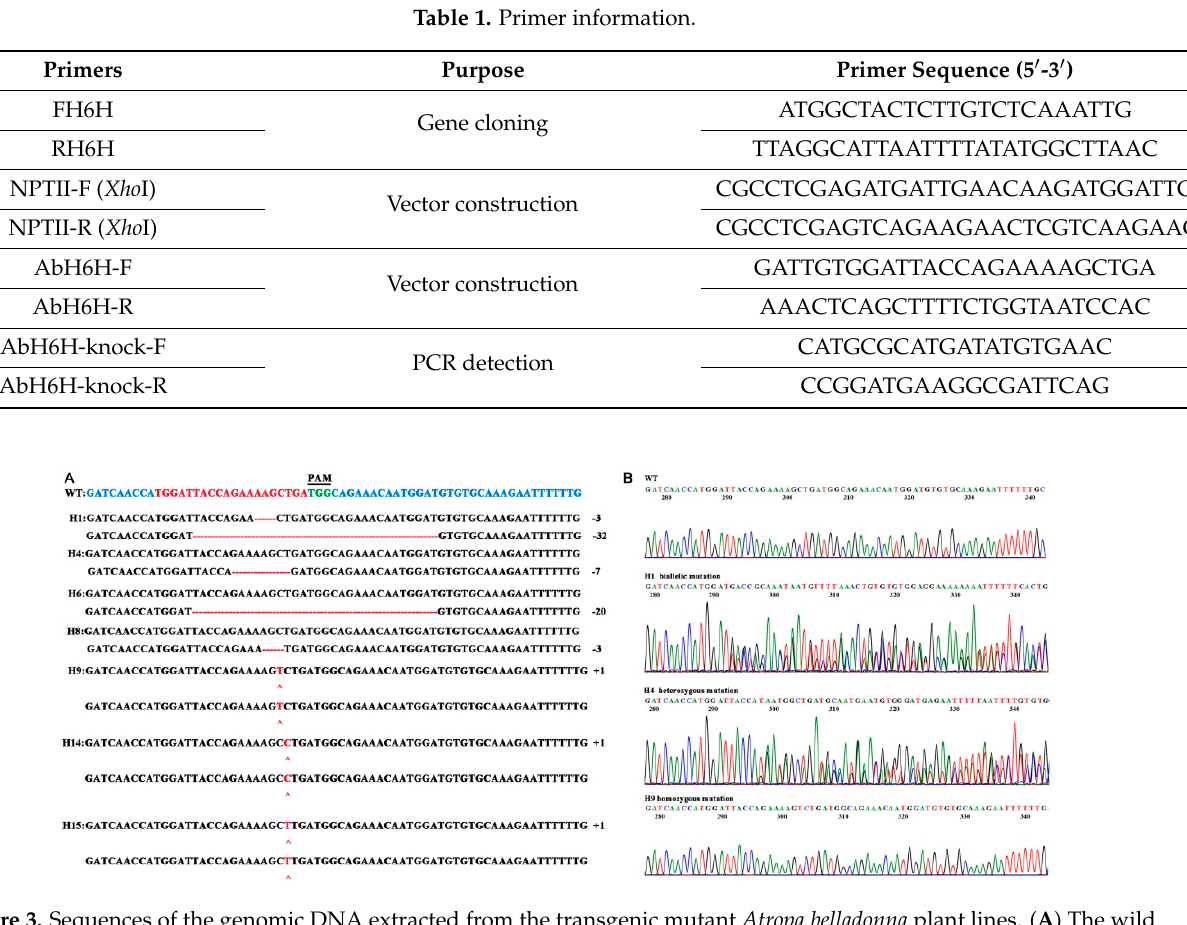
Figure 3. Sequences of the genomic DNA extracted from the transgenic mutant Atropa belladonna plant lines. ( A ) The wild type (WT) sequence appears at the top, with the PAM (TGG) shown in bold green text. DNA insertions and point mutations are added under each sequence in red. Deletions are shown as dashes, and insertions are shown as plus signs. The indel size shows the gain/loss in the amplicon length in the target region. ( B ) Representative chromatograms of WT, biallelic mutation (H1), heterozygous mutation (H4) and homozygous mutation (H9) lines.